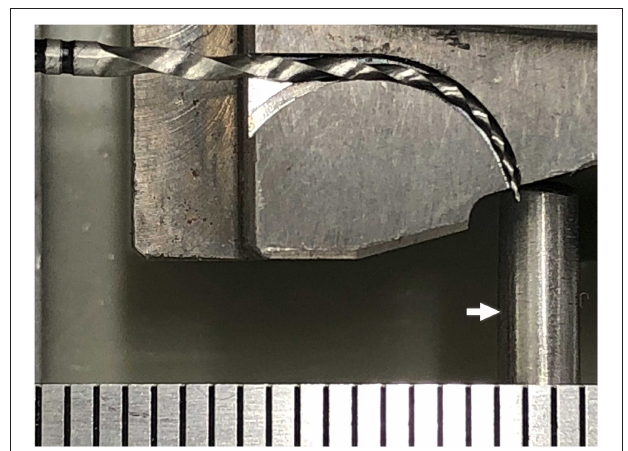
FIGURE 1 | Photograph of a ProFile Vortex size 25, 0.06 taper instrument inserted into the fixture. The probe of the thermometer is indicated by the arrow. Gradation of ruler is in